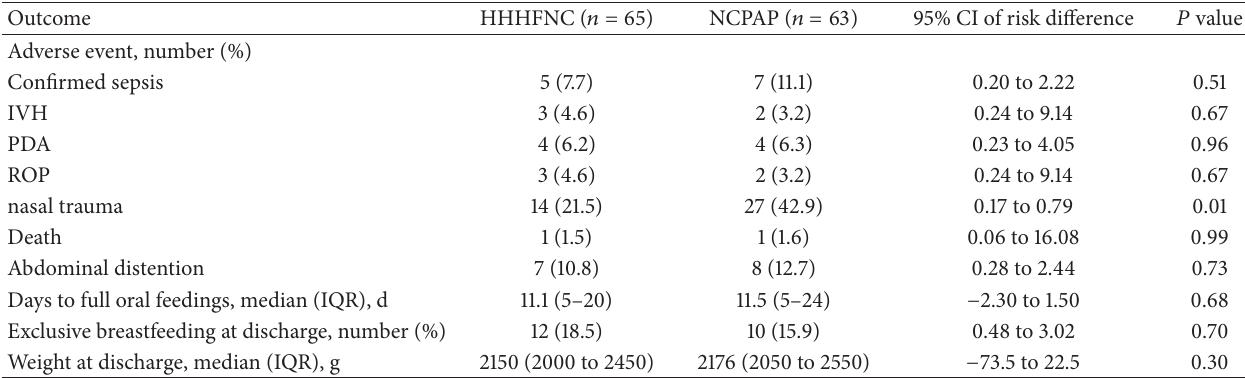
Table 4: Occurrence rates for secondary outcomes in the HHHFNC compared with the NCPAP study